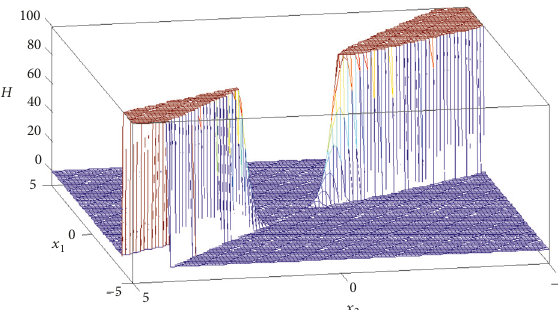
Figure 1: Singular value of linearized system. 1— 𝜎[𝑇 𝑧𝑤 ] ; 2— |𝑇 𝑥 3— |𝑇 𝑢𝑤 | .